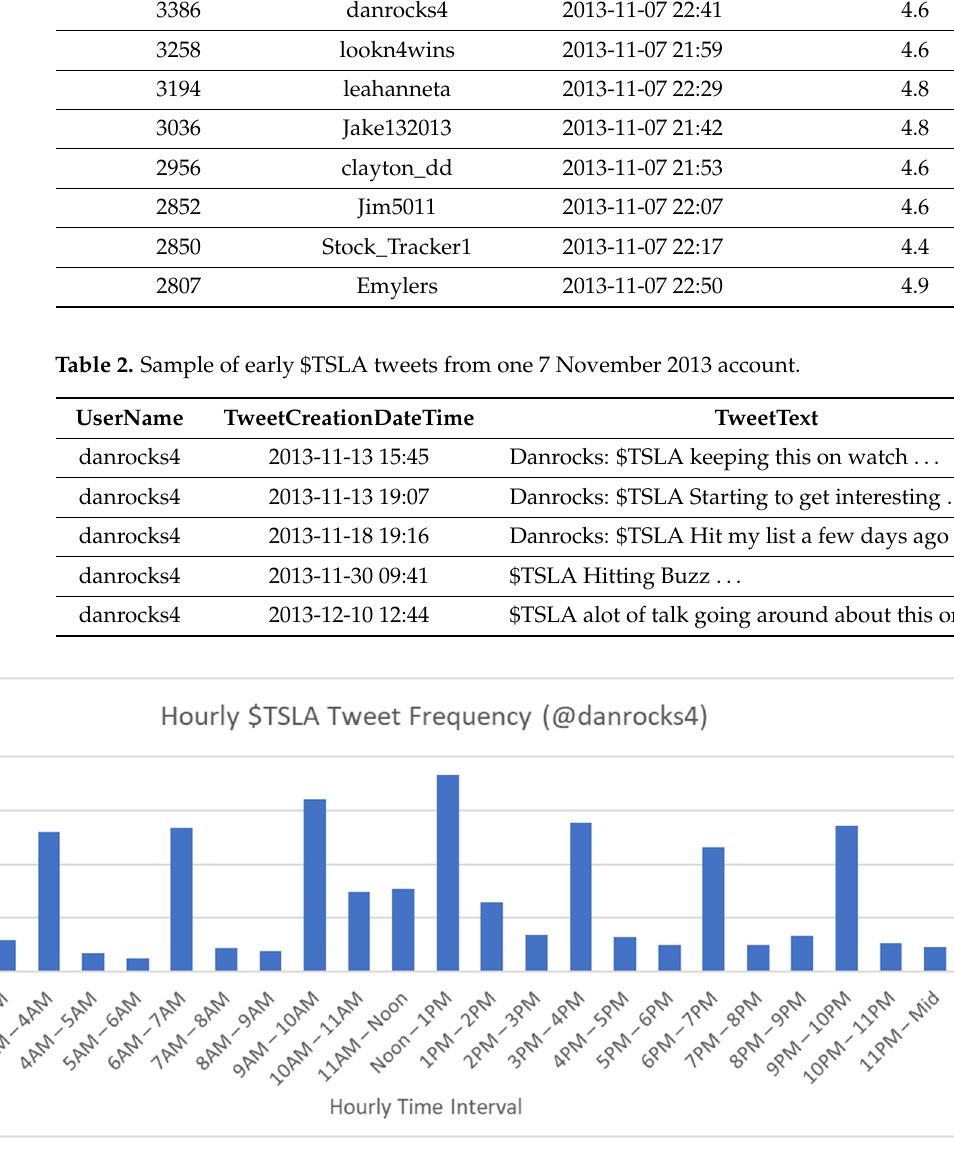
Figure 2. Hourly $TSLA tweet frequency of one 7 November 2013 account over the study